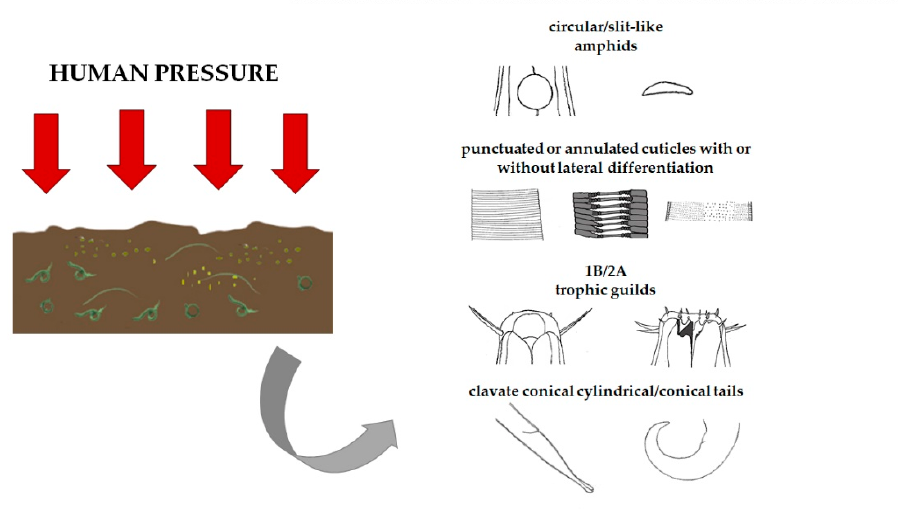
Figure 10. Combination of morpho-functional traits in nematodes inhabiting sediments under human pressure.